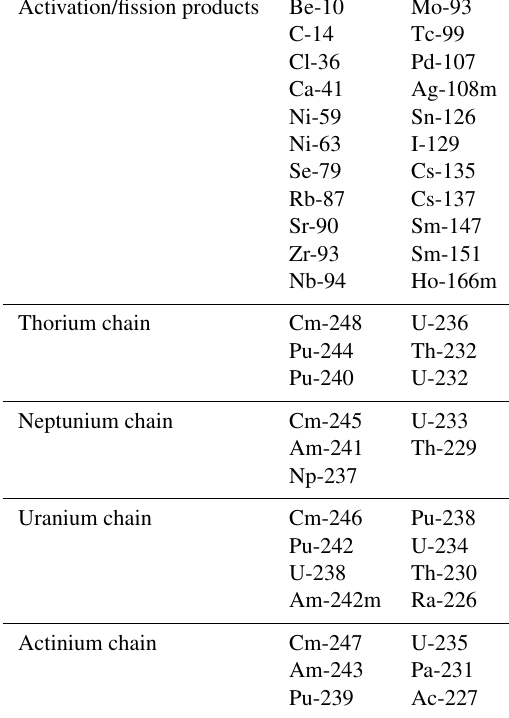
Table 1. The nuclides included in the simplified nuclide scheme of Larue et al. (2013), Fischer-Appelt et al. (2013). Activation/fission products